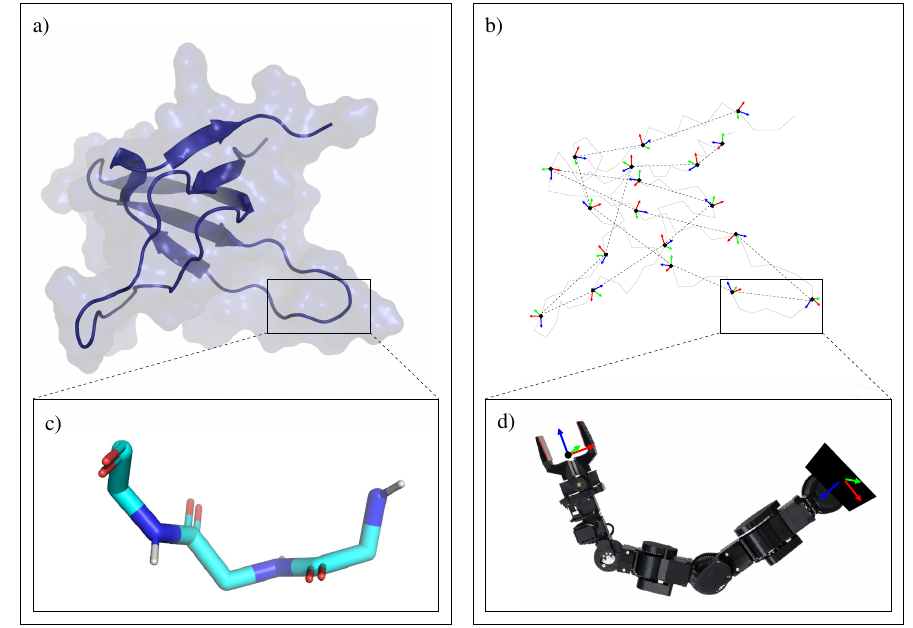
Figure 11. Illustration of the protein subdivision approach. Fragments of three amino-acid residues are treated as kinematic chains, similar to robotic